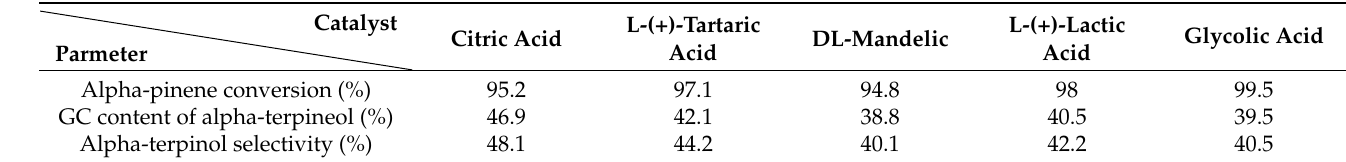
Table 4. Influence of phosphoric acid on the hydration reaction when acetic acid was used as the auxiliary